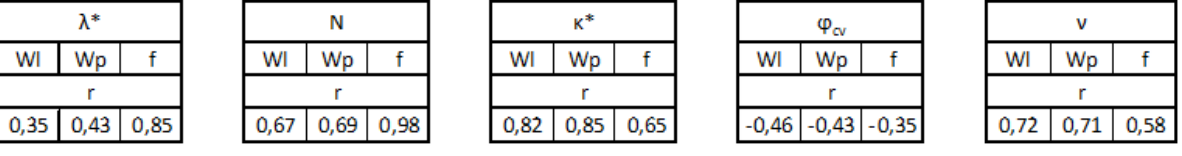
Table 2. Correlation values r